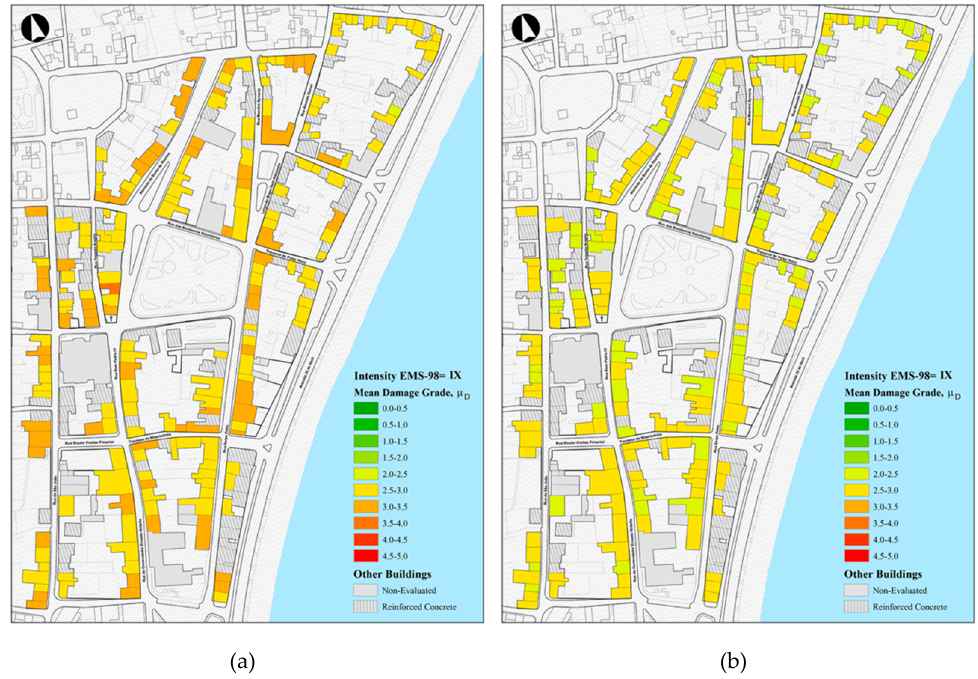
Figure 3. Mapping of damage scenarios for the old city centre of Horta: ( a ) before and ( b ) after the application of seismic retrofitting strategies, adapted from Ferreira et al. [30].